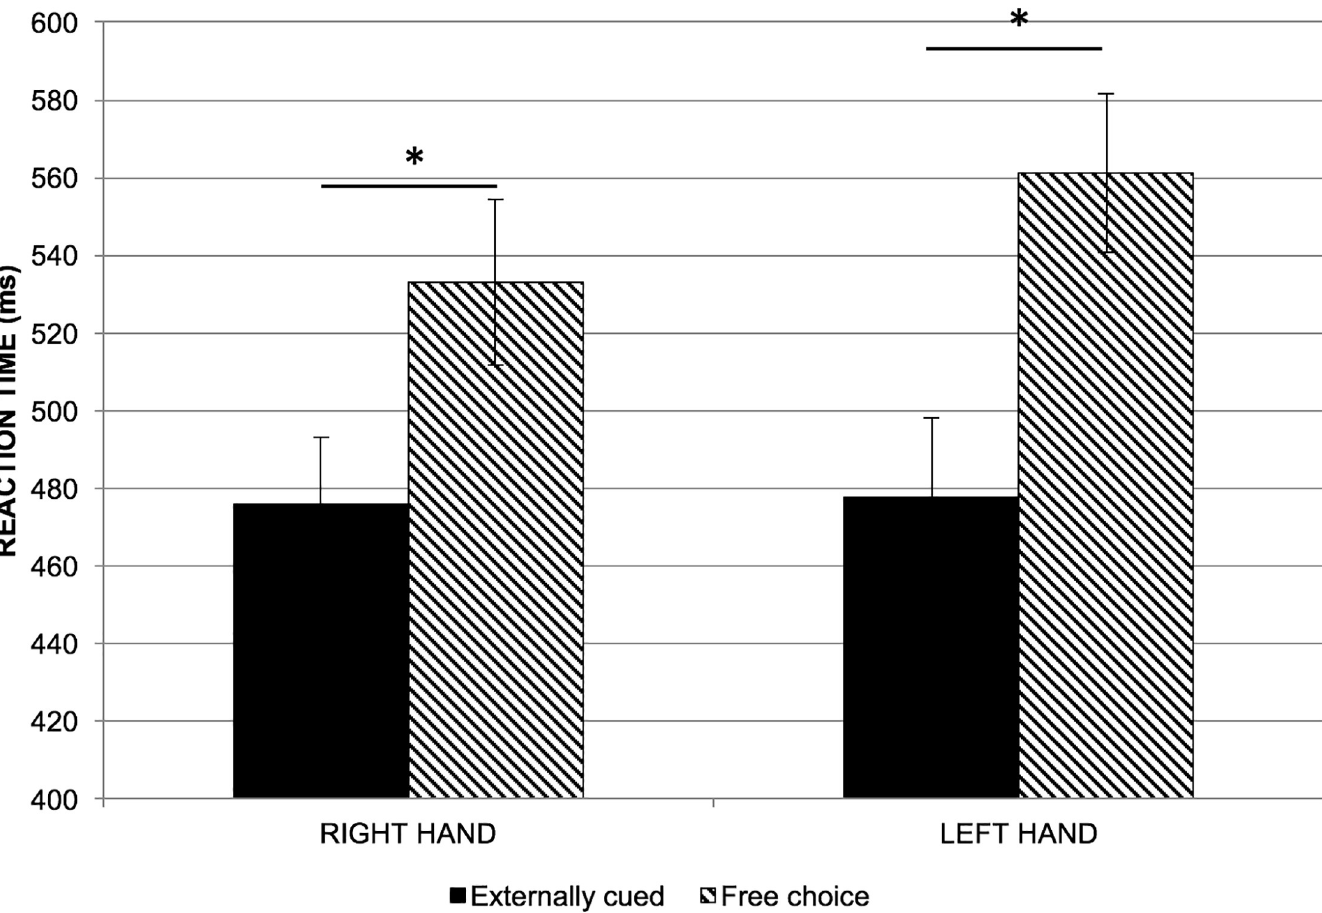
Fig 5. Reaction time for externally-cued versus free-choice trials. Shows the mean reaction time across subjects for the right and left hands in externally-cued and free-choice trials. Both hands had similar reaction times which was higher for free-choice trials than for externally-cued trials. Bars represent mean reaction time for each hand and condition. Black bars = externally-cued trials; Striped bars = free-choice trials. Error bars represent standard error of mean. Asterisks indicate p < 0.05.